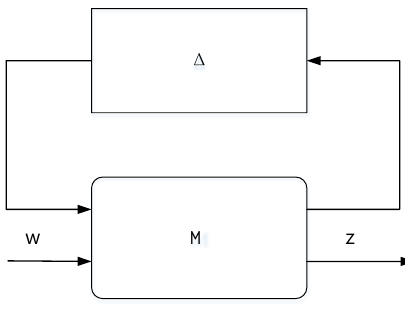
Figure 8. Standard M- 𝛥 configuration.